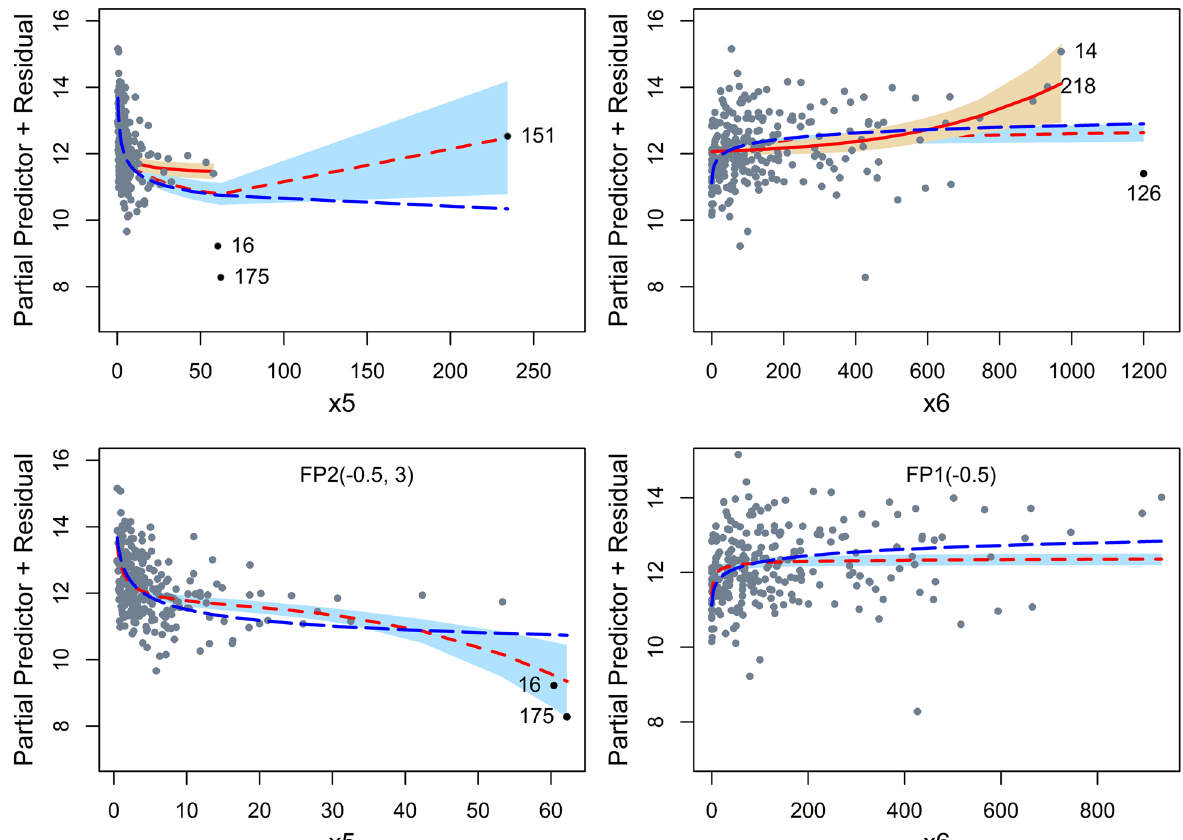
Fig. 4 Data A250. Functional forms of variables x5 and x6. Top: the estimate of the functional form from complete data (red, short-dashed), data without IPs identified using the L-1 approach (solid line) and true function (blue, long-dashed line). Bottom: the estimate of the functional forms of variables x5 (left) and x6 (right) after the removal of observation (126, 151) and (14, 126), respectively. Please note the different